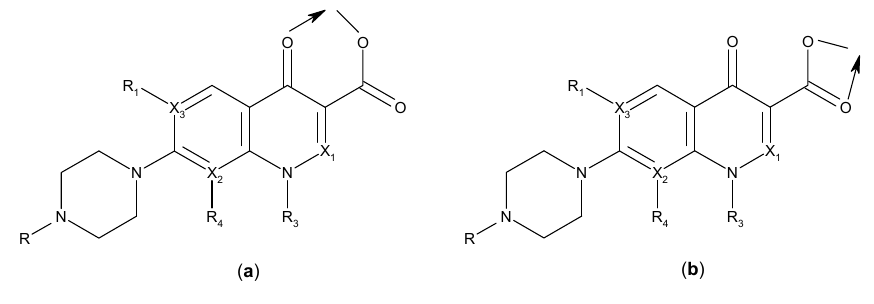
Figure 4. Main coordination modes of